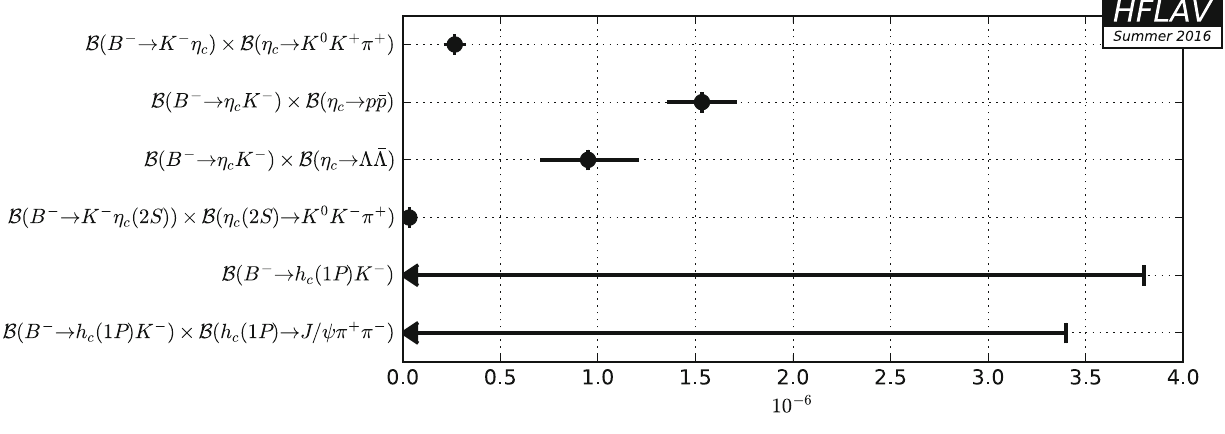
Fig. 132 Summary of the averages from Table 163